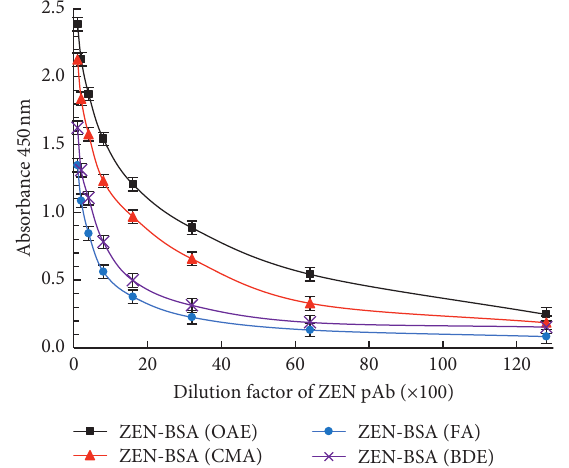
Figure 9: The inELISA titers measurement for ZEN pAb. Each point represents the mean of three replicates ( n � 3). (Figure 10). The regression equation, R 2 value, and IC50 value of the inhibition curve are shown in Table 2. The IC50 value for ZEN by icELISA of each immunogen ZEN- BSA (OAE), ZEN-BSA (CMA), ZEN-BSA (FA), and ZEN- BSA (BDE) were 11.67 μ g/L, 16.29 μ g/L, 20.92 μ g/L, and